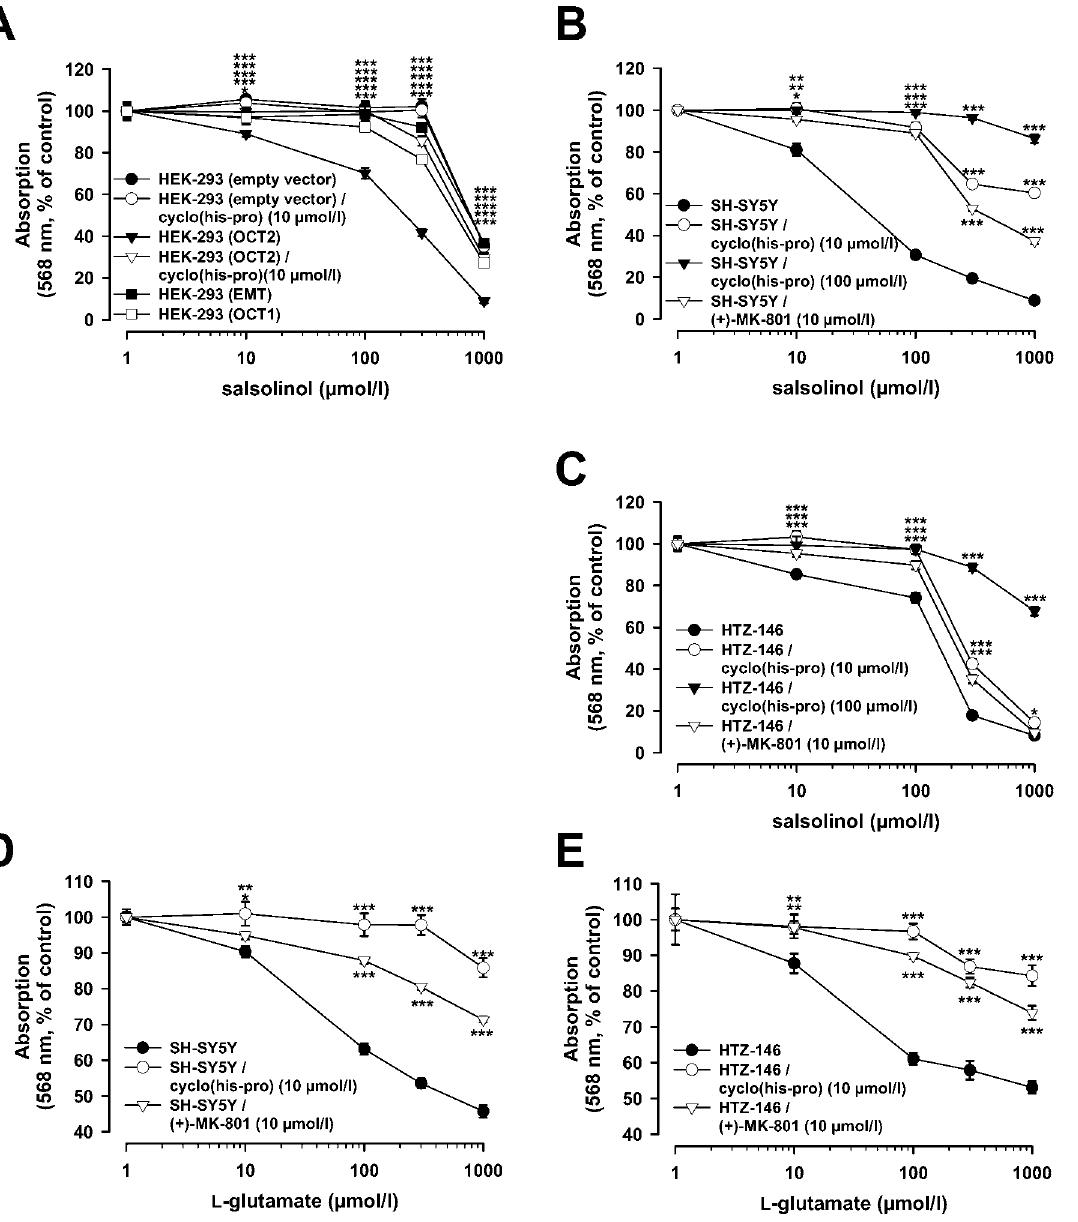
Figure 4. Selective cytotoxic effects of salsolinol and cytoprotective effects of cyclo(his-pro) toward OCT2-expressing cells. Cell viability was assessed by MTT reduction assay; resulting formazane formation was determined by absorbance at 568 nm. (A) After 48 h exposure to different concentrations of salsolinol, HEK-293 cells expressing OCT2 showed higher cell loss than HEK-293 cells expressing empty vector, OCT1 or EMT. The respective EC 50 values (95% confidence intervals) for salsolinol were 192 (174 to 212), 1112 (900 to 1375), 627 (525 to 748), and 998 (780 to 1277) m mol/l. 12 h of incubation with cyclo(his-pro) (10 m mol/l) prior to salsolinol treatment prevented degeneration of OCT2-transfected HEK-293 cells (EC 50 =763 (655 to 889) m mol/l), but had no effect on empty vector transfected HEK-293 cells (EC 50 =1073 (870 to 1324) m mol/l) (n=24–48; mean 6 s.e.m.; *P , 0.05, ***P , 0.001). (B and C) Cytotoxicity of salsolinol and its protection by pretreatment with cyclo(his-pro) (10 and 100 m mol/l) were confirmed in endogenously OCT2-expressing SH-SY5Y and HTZ-146 cells. The EC 50 values in non-pretreated, and for 1 h with 10 m mol/l and 100 m mol/l cyclo(his-pro) pretreated SH-SY5Y cells were 49 (44 to 56), 1054 (888 to 1251), and 6568 (5313 to 8119) m mol/l of salsolinol, and the respective values in HTZ-146 cells were 138 (120 to 160), 318 (268 to 377), and 2176 (1727 to 2741) m mol/l of salsolinol. (D and E) Cyclo(his-pro) prevented SH-SY5Y and HTZ-146 cells from glutamate-induced cytotoxicity. EC 50 values for glutamate were 389 (323 to 467) vs. 6461 (4132 to 10102) m mol/l in SH-SY5Y cells, and 585 (490 to 699) vs. 4768 (3660 to 6211) when comparing non-pretreated cells with cells pre-treated for 1 h with 10 m mol/l cyclo(his-pro). Cell death caused by glutamate (D and E) as well as salsolinol (B and C) was also attenuated in the presence of a specific inhibitor of NMDA receptor-operated calcium channels (( + )-MK-801, 10 m mol/l), indicating that blockage of excitotoxic calcium entry may contribute to the protective mechanism of cyclo(his-pro). The EC 50 values for glutamate were 1986 (1744 to 2261) in SH-SY5Y and 2316 (1723 to 3112) m mol/l in HTZ-146 cells, and the EC 50 for salsolinol was 475 (430 to 524) in SH-SY5Y and 242 (202 to 291) m mol/l in HTZ-146 cells (n=16–32; mean 6 s.e.m.; *P , 0.05, **P , 0.01, ***P , 0.001).